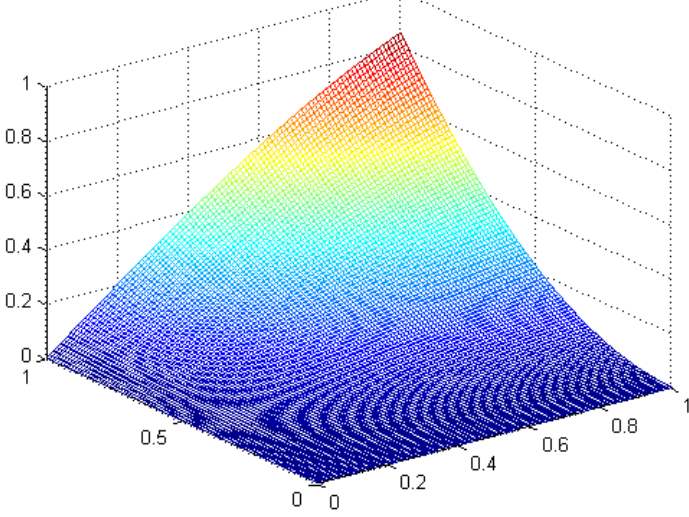
Figure 1. The Exact Solutions u ( x , t ) for Equation (20) when µ = ν =